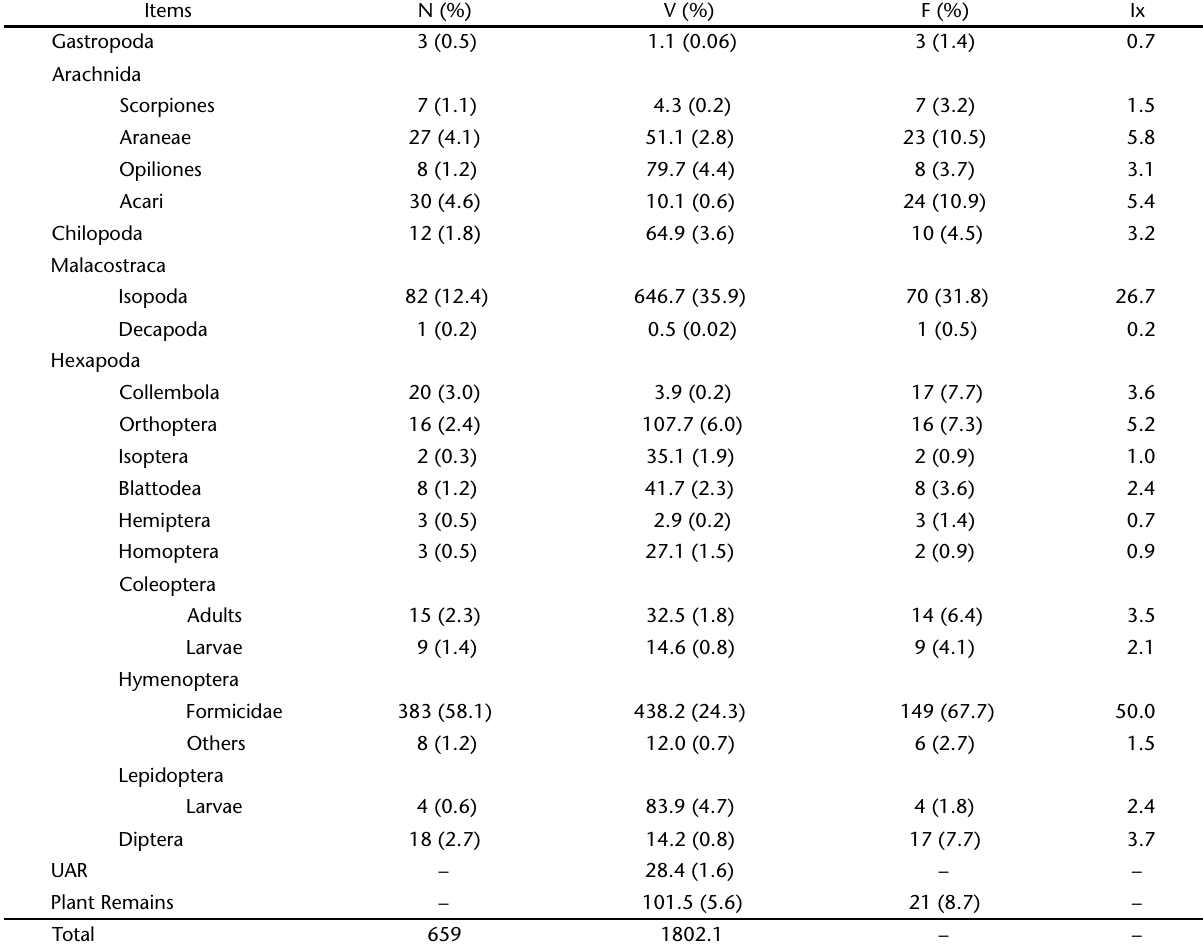
Table I. Number (N), volume (V, mm 3 ), frequency of occurrence (F) (percentage in parenthesis) and Importance Index (Ix) of each food item in the diet of I. parva (N = 220) in Santuário Ecológico da Serra da Concórdia, Barra do Piraí/Valença. (UAR) Unidentified arthropod